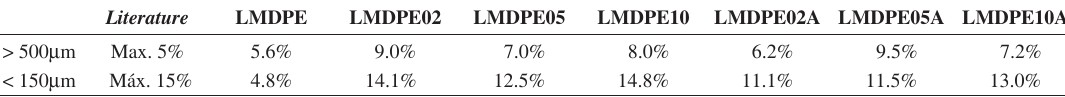
Table 4. Percentage of large and small composite particle sizes.